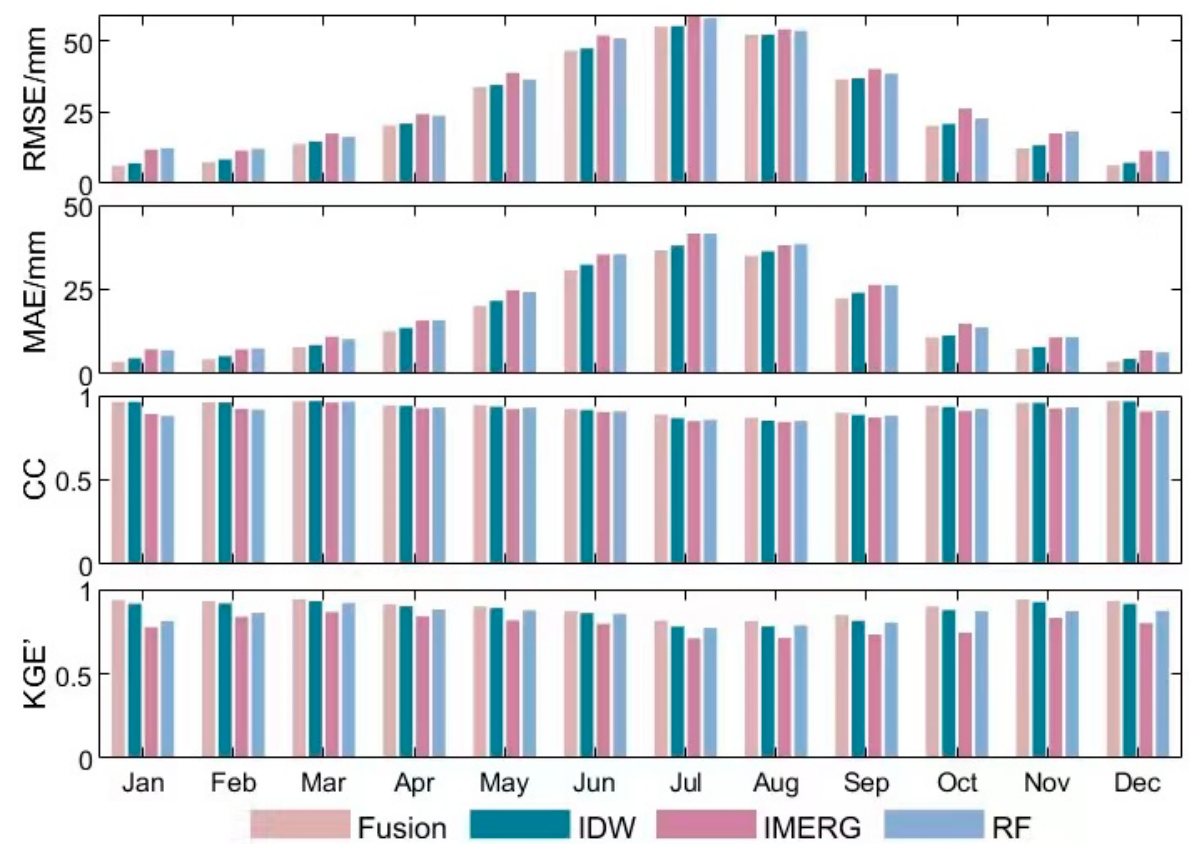
Figure 7. Comparison of monthly mean error during 2009–2018.